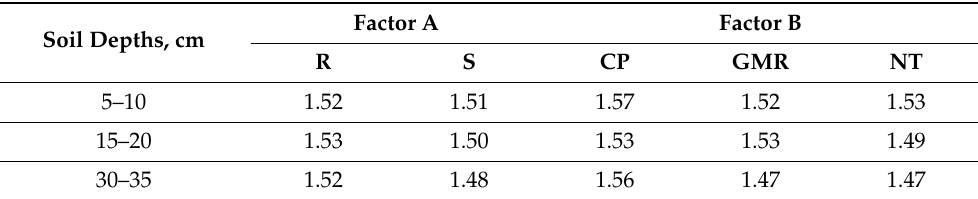
Table 1. The influence of tillage intensity and straw retention on soil bulk density (Mg m − 3 ) at different soil